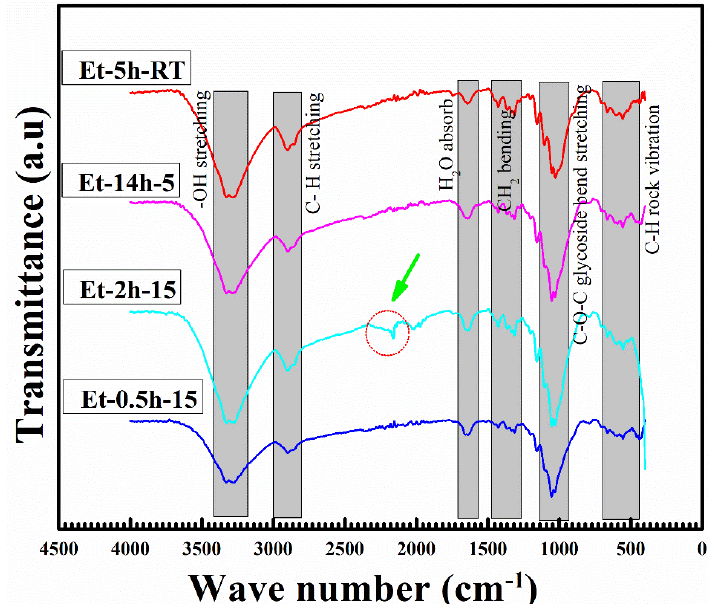
Figure 4. FTIR analysis profile of the coated cotton fabrics.